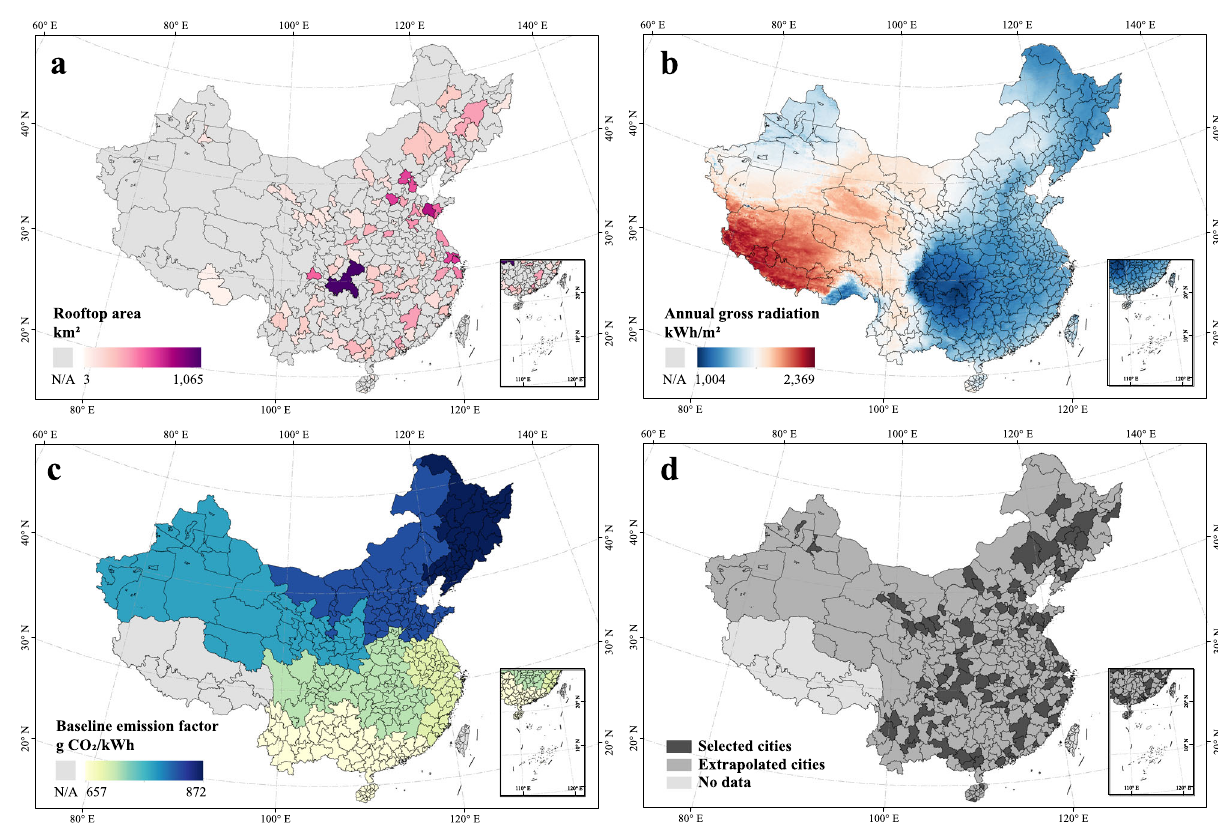
Fig. 1 | Overview of the study area and city representations. a Geographical scope of the vectorized rooftop data, b solar radiation data, and c grid emission data. d Scope ofthe studyarea extrapolated from 86cities with measured rooftop